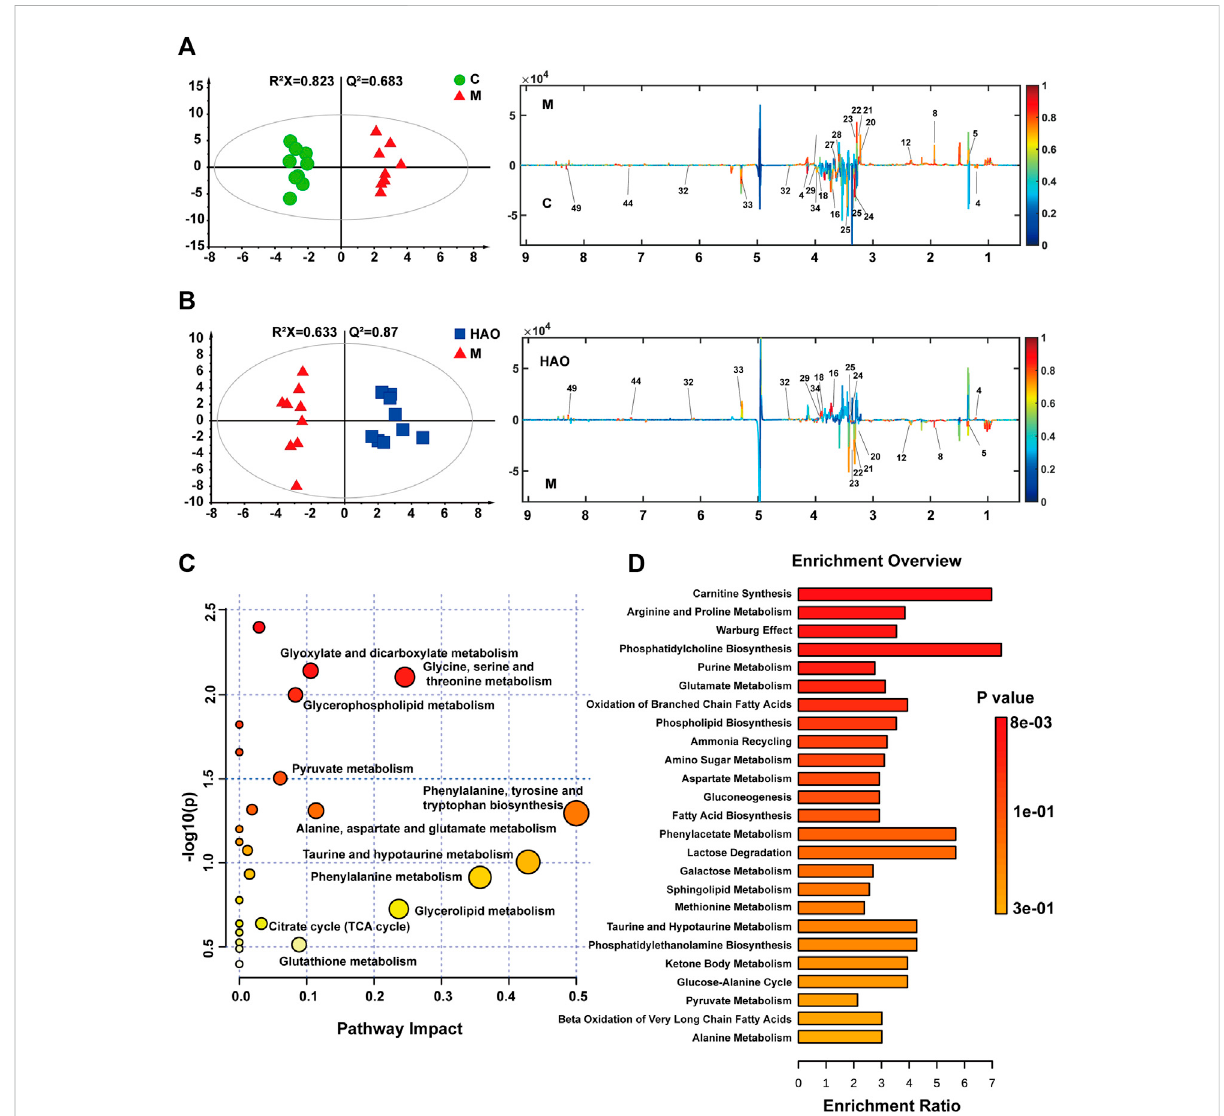
OPLS-DA score plots (left) and the corresponding loading (right) plots derived from 1H NMR spectra of liver tissue (A,B) . Analysis of metabolic pathways related to high fructose-induced metabolic syndrome (C) . The pathway enrichment analysis based on 1H-NMR metabolomics of liver tissue (D)